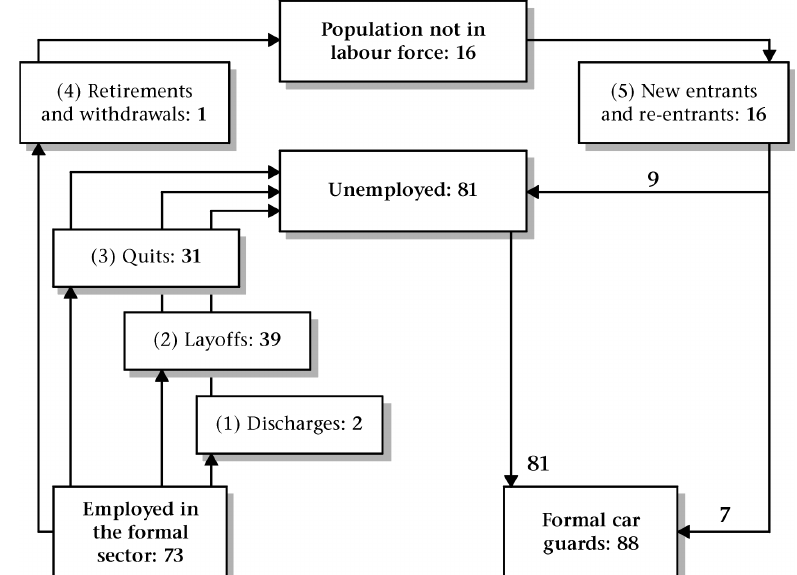
Figure 1: The stock-flow model – formal car